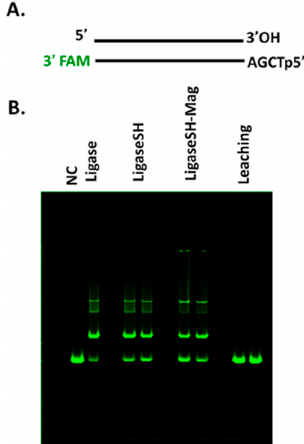
Figure 3. Comparison of sticky end ligation efficiency between soluble and immobilized T4 DNA ligases. Soluble Ligases (Ligase and LigaseSH) are compared to the immobilized (LigaseSH-Mag) and bead leachate for sticky end ligation. The supernatant of the LigaseSH-Mag bead slurry (leachate) was collected and assayed for ligase activity. ( A ) A fluorophore-labeled synthetic DNA duplex with a four-nucleotide overhang (AGCT) was used for ligation reactions. ( B ) Ligation reactions were performed in 1 × T4 DNA Ligase Reaction Bu ff er at 23 ◦ C for 2 h and analyzed by polyacrylamide gel electrophoresis of the samples followed by fluorescent scanning. The assays of the SNAP-tagged T4 DNA ligase were performed in